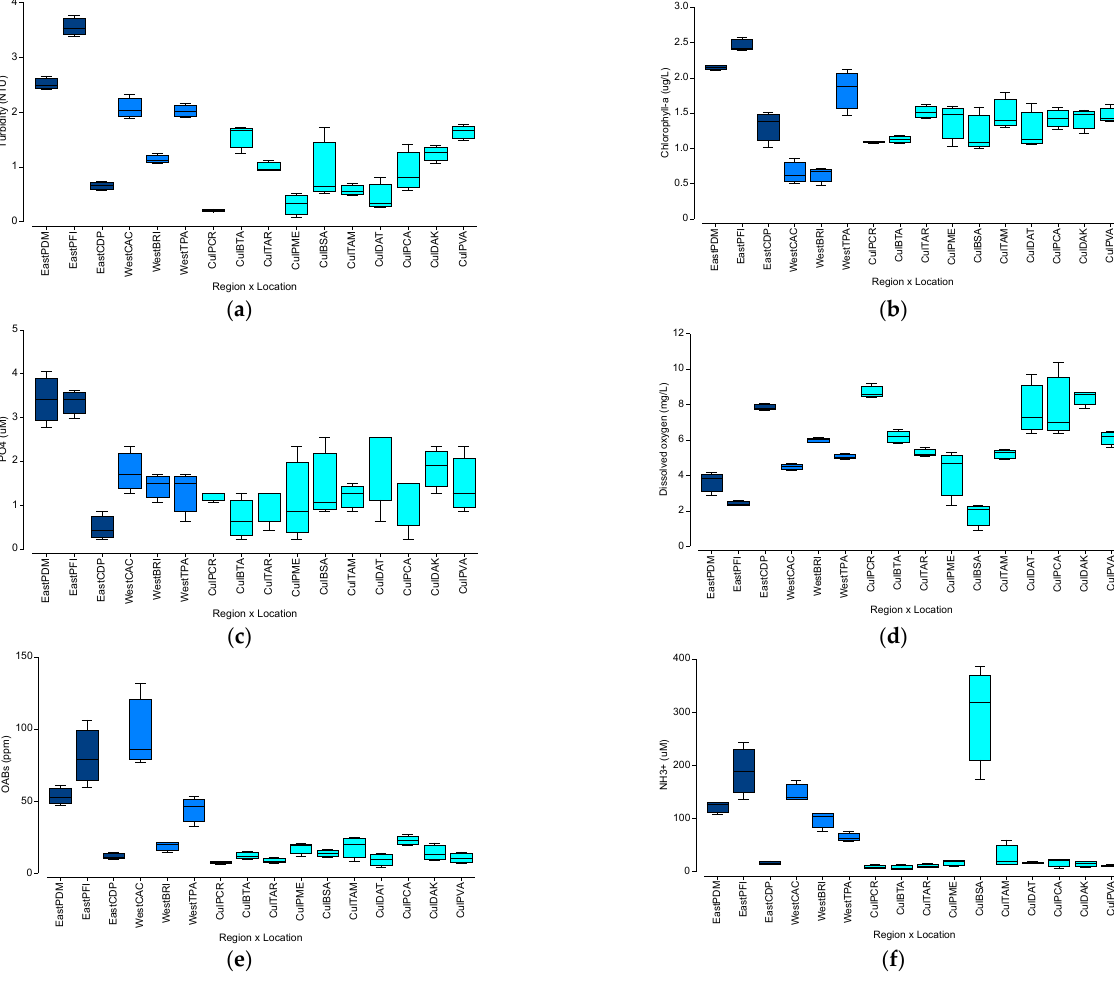
Figure 7. Spatial patterns in the mean values of six water quality variables by region (East, West, Culebra) and by locality: ( a ) Turbidity; ( b ) Chlorophyll- a ; ( c ) Phosphate (PO 4 ); ( d ) Dissolved oxygen; ( e ) Optical brighteners (OABs); and ( f ) Ammonia (NH 3+ ). Refer to the Methodology for the description of acronyms.